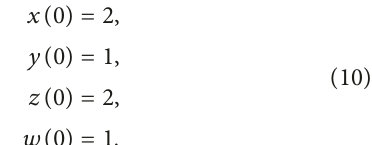
Figure 1. The complex dynamic behaviors of Experiment 1 are shown in Figures 2–9.